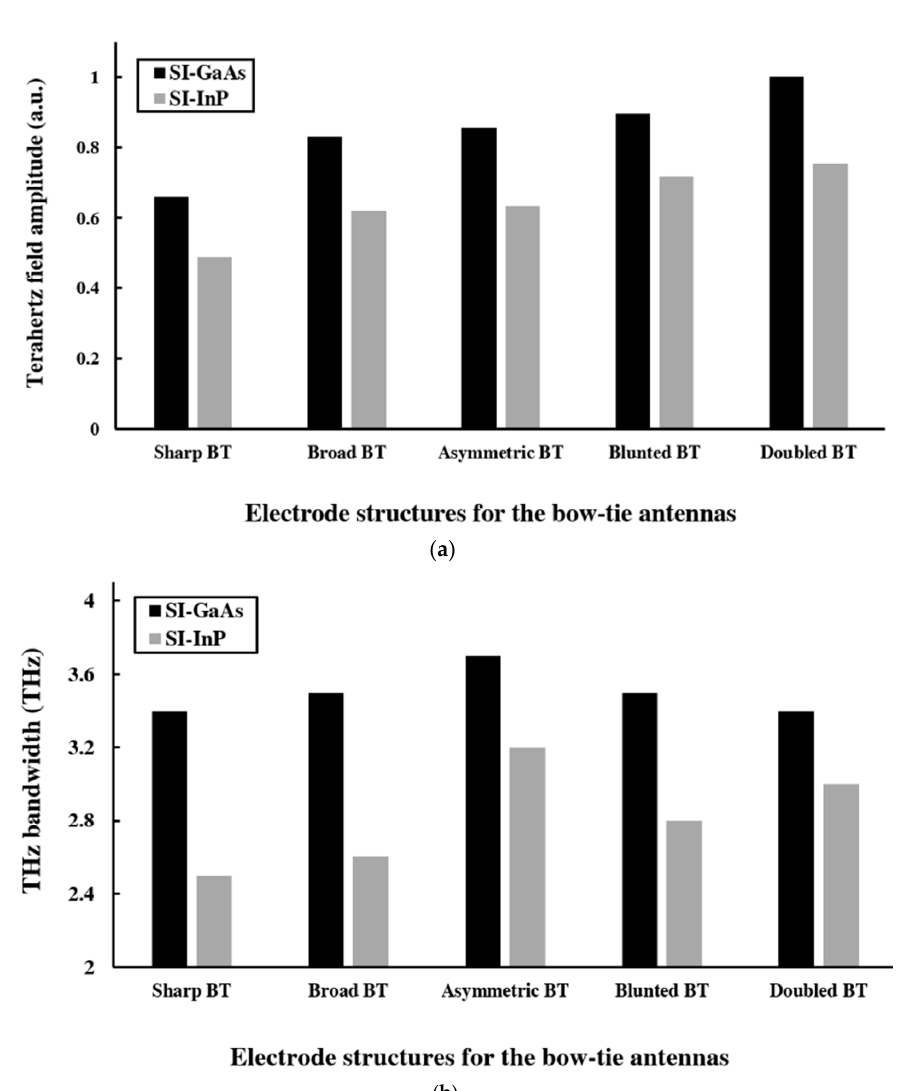
Figure 6. The ( a ) THz field amplitude and ( b ) THz bandwidth for PC THz emitters based upon SI-GaAs (black) and SI-InP (grey) with BT antennas having the Sharp BT, Broad BT, Asymmetric BT, Blunted BT, and Doubled BT structures.